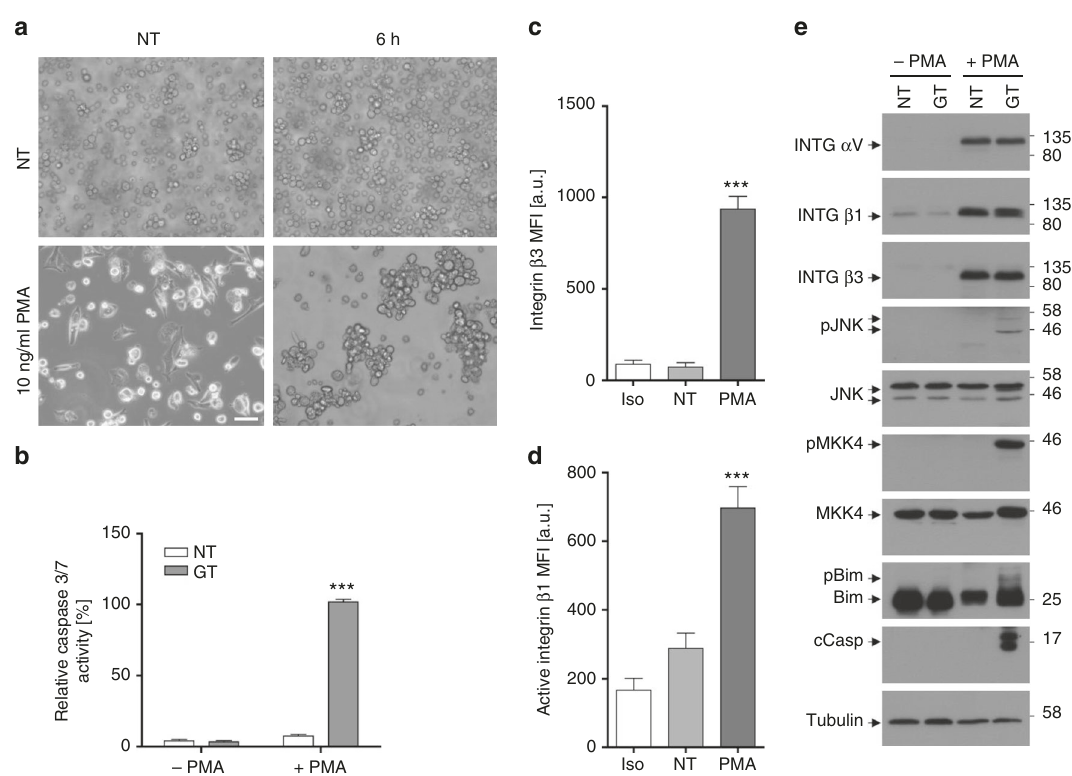
Fig. 7 Induction of integrins by PMA confers sensitivity to anoikis. a Phase contrast microscopy analysis of K562 cells treated with 10 ng/ml PMA for 96 h before adding 1 μ M GT for 6 h. While untreated (NT) cells grow in suspension, PMA-treated cells adhere to the dish and become sensitive to GT-induced detachment. Scale bar = 100 µ m. b GT induced caspase-3/-7 activity (taken as 100%) in PMA-treated adherent K562 cells ( + PMA) but not in undifferentiated suspension cells ( − PMA). c , d FACS analysis of K562 cells showing that PMA increased the surface expression of integrin β 3 ( c ) and